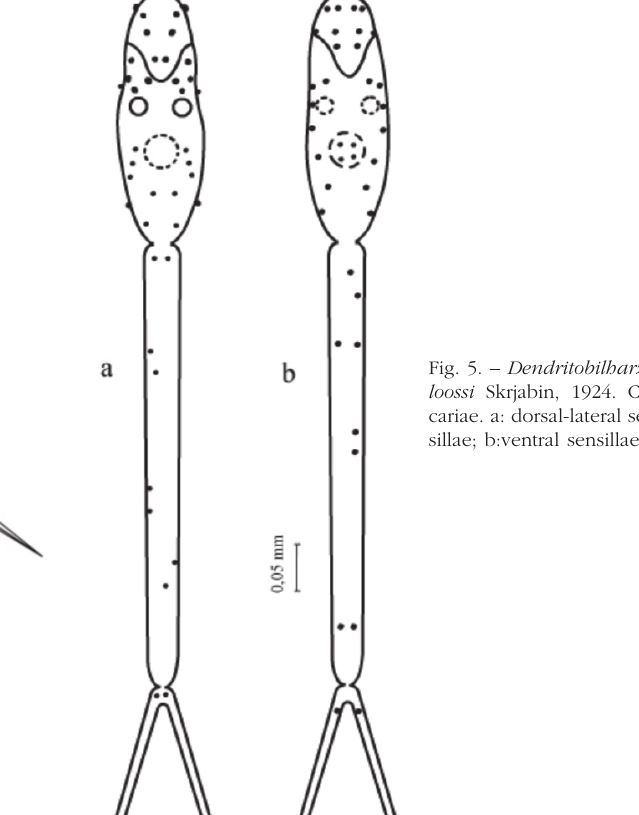
Fig. 5. – Dendritobilharzia loossi Skrjabin, 1924. Cer- cariae. a: dorsal-lateral sen- sillae; b:ventral